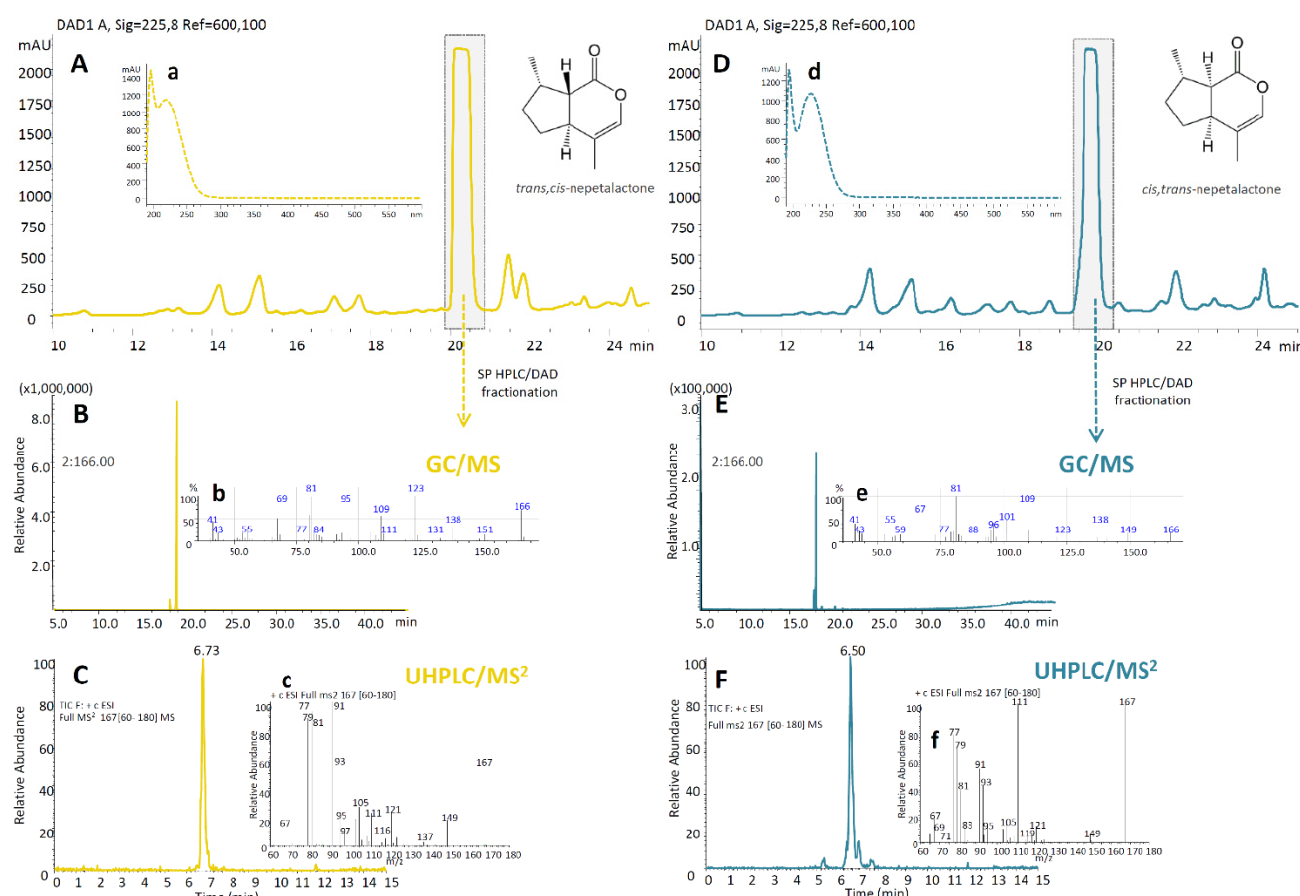
Figure 1. Semipreparative HPLC/DAD chromatograms of Nepeta rtanjensis ( A ) and N. cataria ( D ) essential oils (EO) acquired at λ = 230 nm, and corresponding UV spectra of trans,cis -nepetalactone (a) and cis,trans –nepetalactone (b). Isolated nepetalactones were subjected to structural characterization adopting GC/MS ( B , E ) and UHPLC/MS 2 ( C , F ) analyses. Corresponding GC/MS (b,e) and MS 2 spectra (c,f) are also presented.